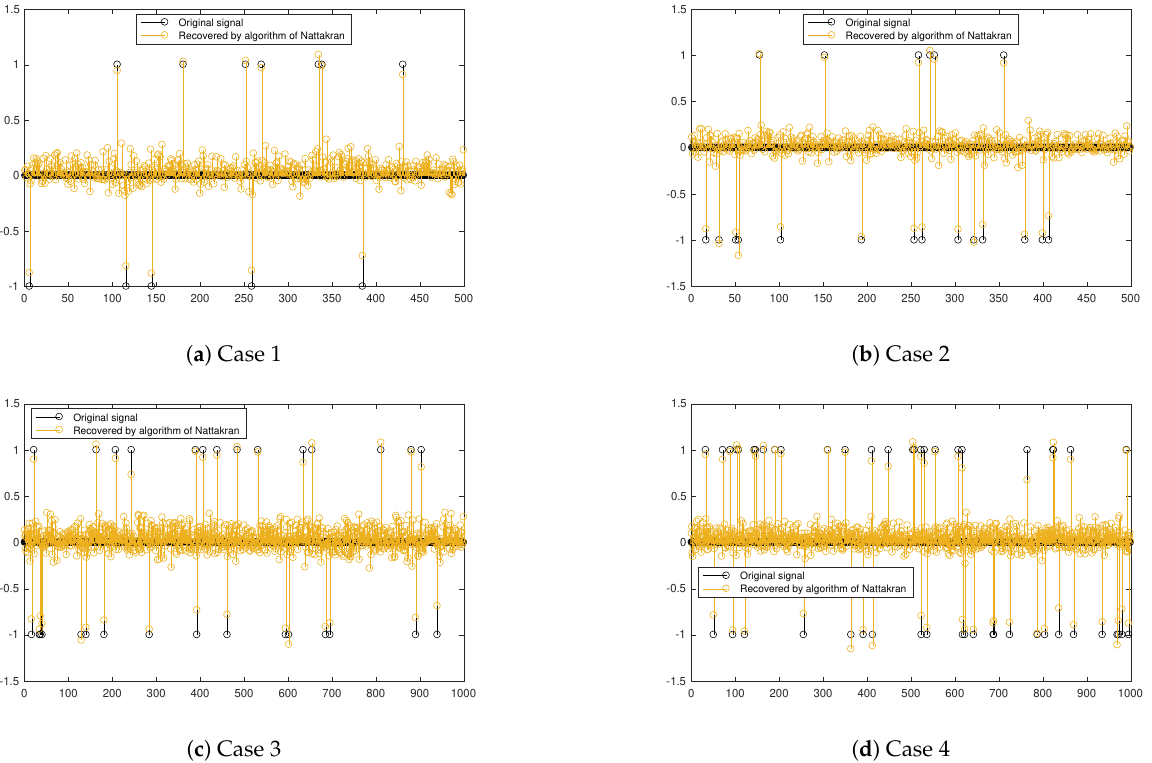
Figure 12. Recovery result by using Nattakran (19) in Example